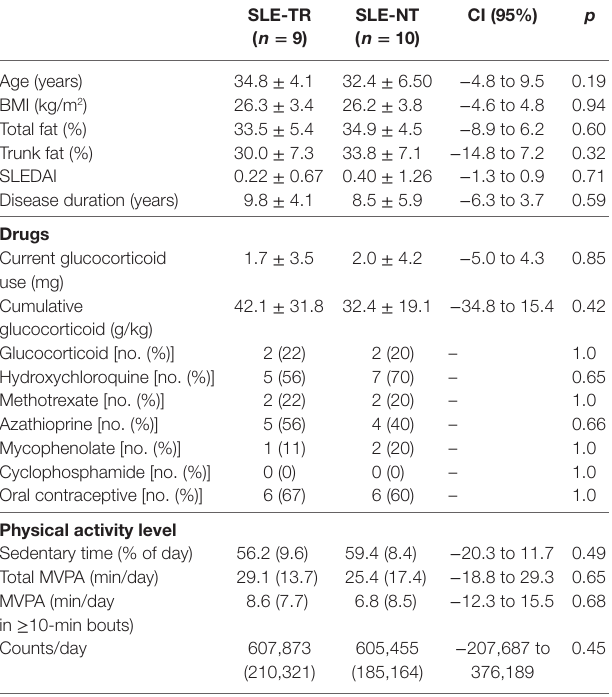
TABLE 1 | Demographic, current clinical and treatment data and physical activity levels in SLE patients at